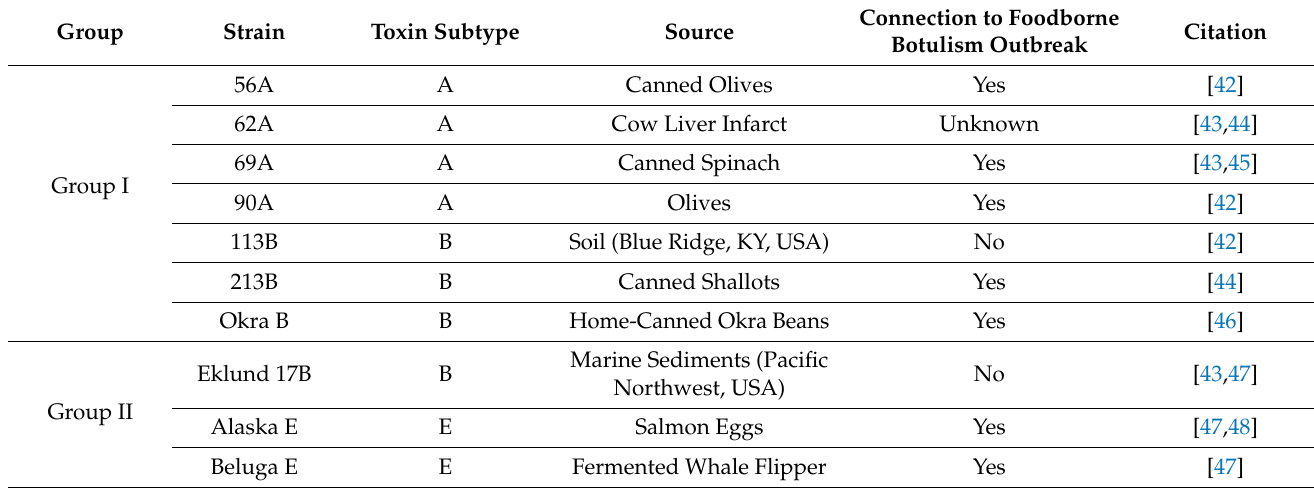
Table 1. Strains used in this